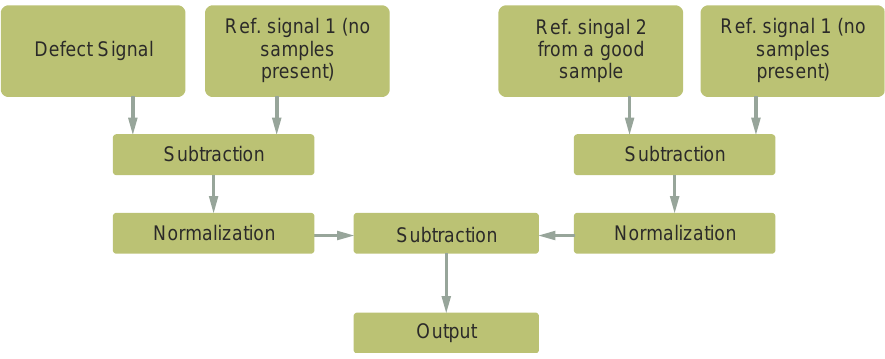
Figure 13. Diagram block using normalization to reduce lift-off effect (adapted from